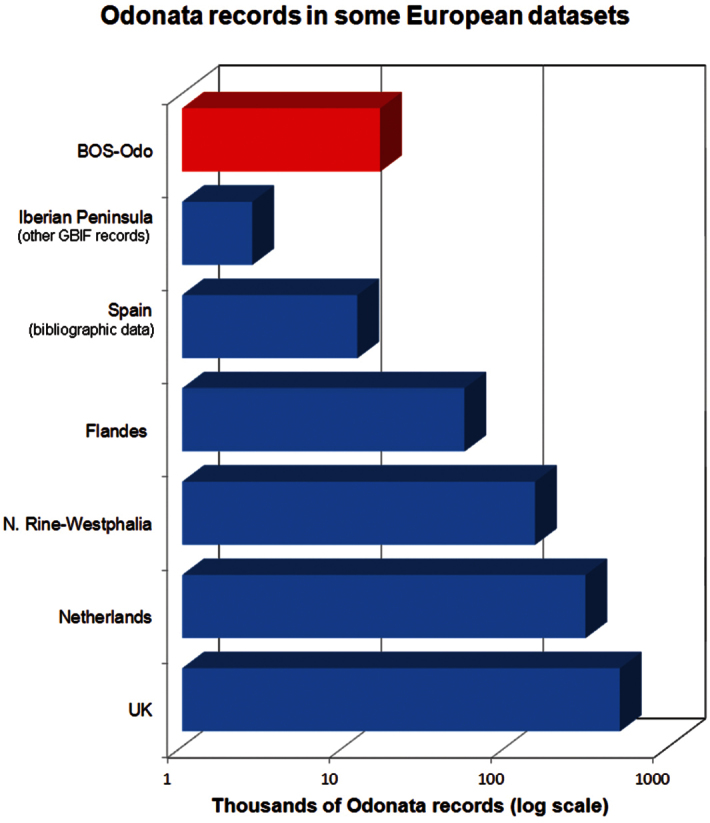
Odonata data records in major European data sets. Sources: BOS-Odo (this dataset); Flandes (De Knijf and Anselin 2010); Iberian Peninsula other GBIF data (GBIF dataportal http://data.gbif.org); Netherlands (Termaat et al. 2010); North Rhine-Westphalia (Conce et al. 2010); United Kingdom (Parr 2010).